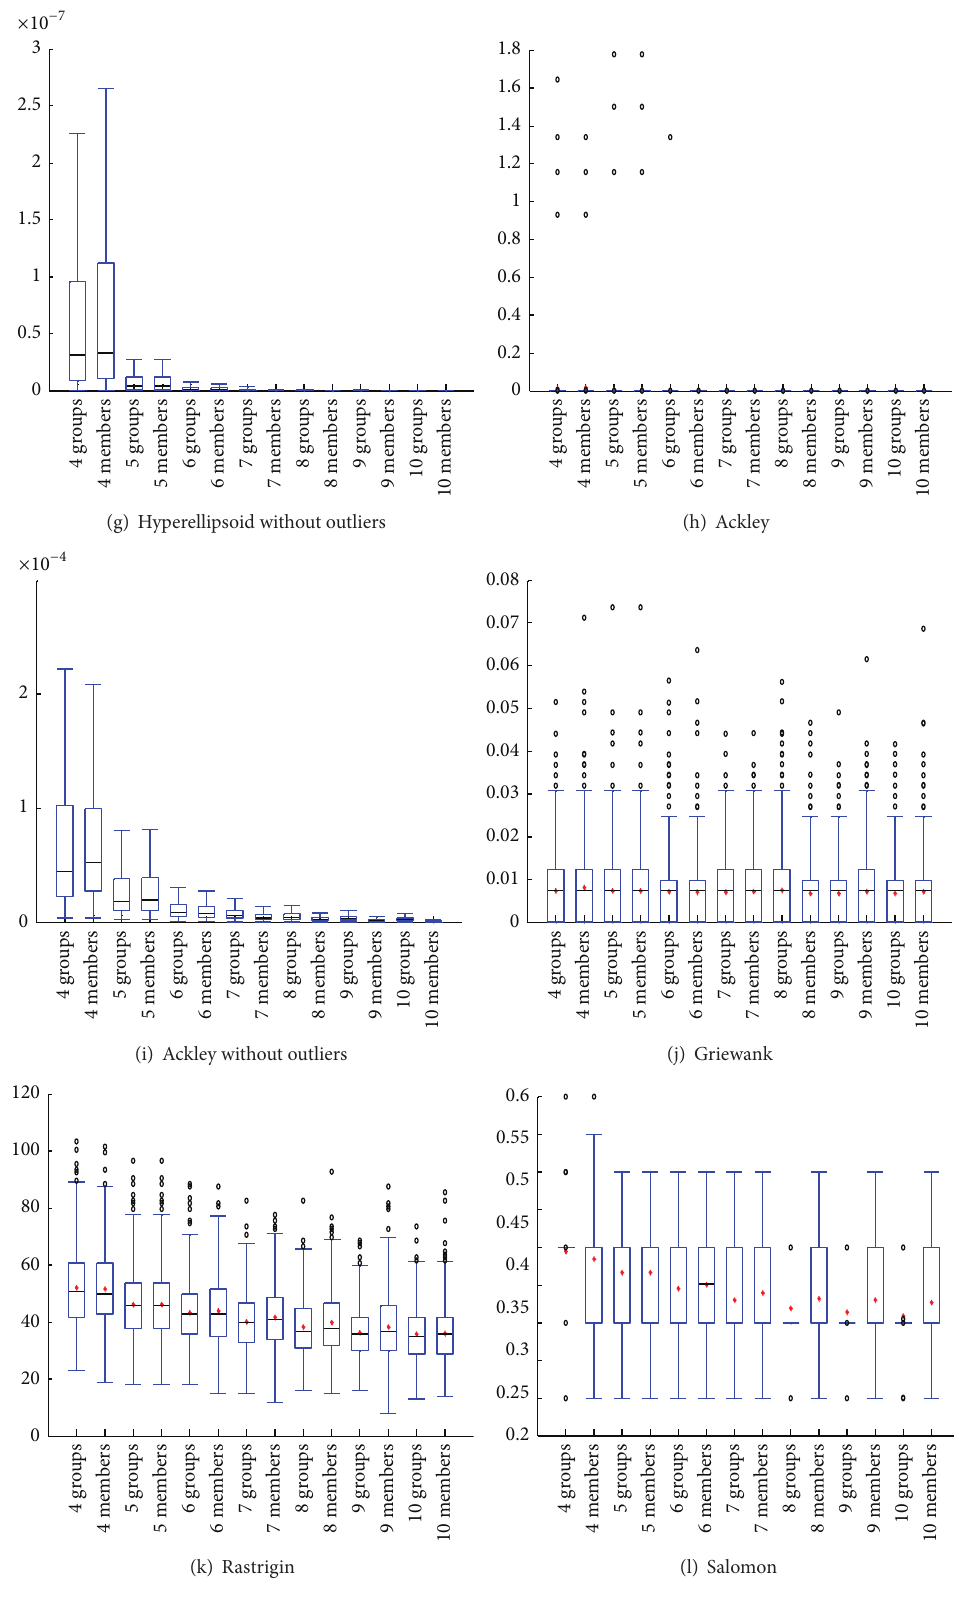
Figure 7: Effect of number of groups and group